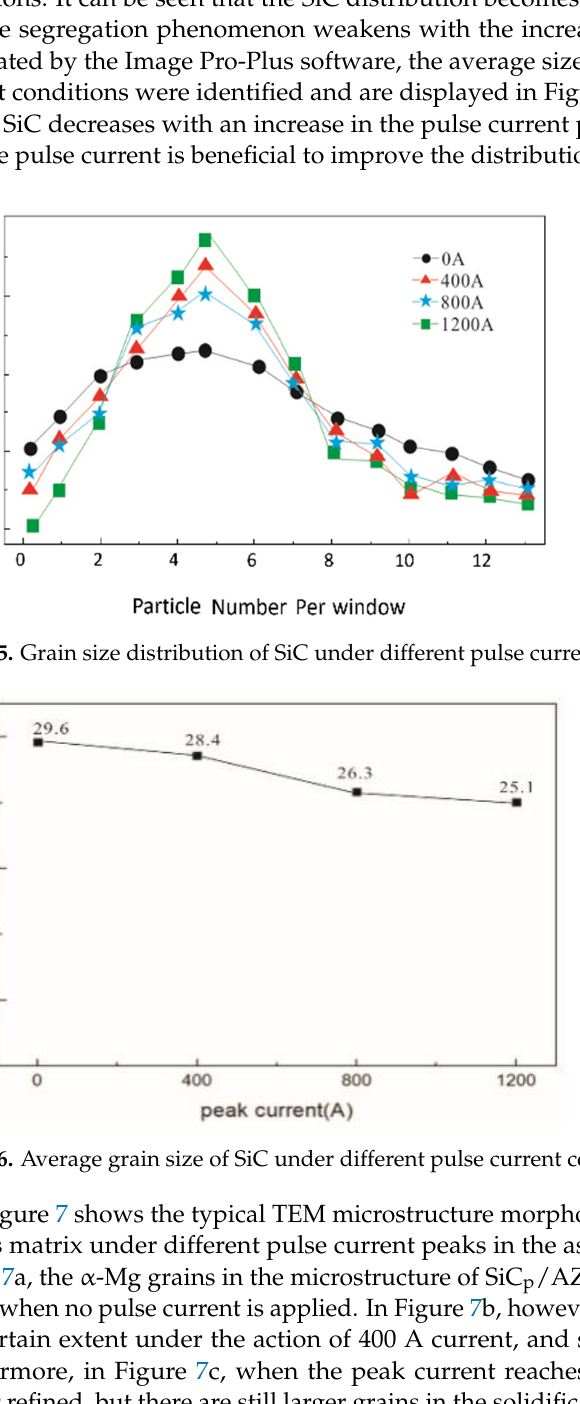
Figure 4. SEM images showing 500 times SiC p /AZ91D composite particle distribution. ( a ) 0 A; ( b ) 400 A; ( c ) 800 A; ( d ) 1200 A.